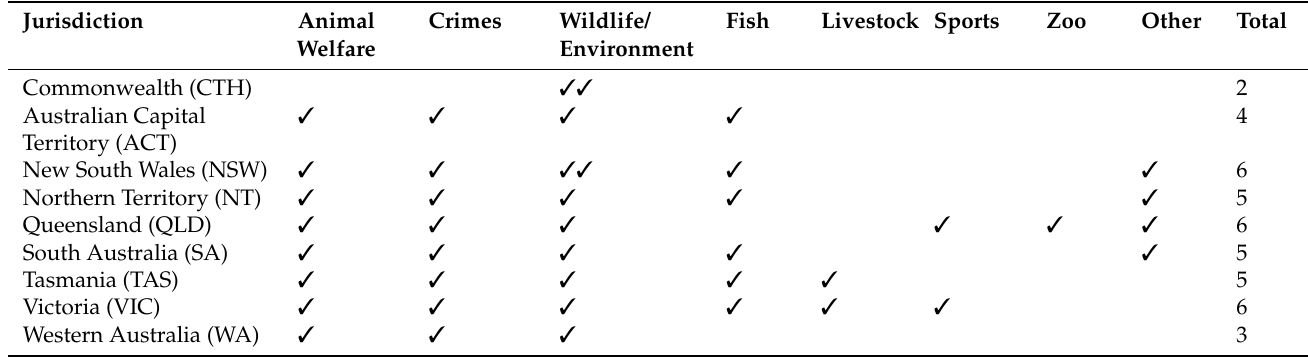
Table 1. Statutes which include provisions for animal welfare protection in various Australian jurisdictions. ‘Other’ categories include chemical use statutes, racing statutes, a summary offences statute and a police powers statute. For a detailed list of all 42 statutes, refer to Appendix A.